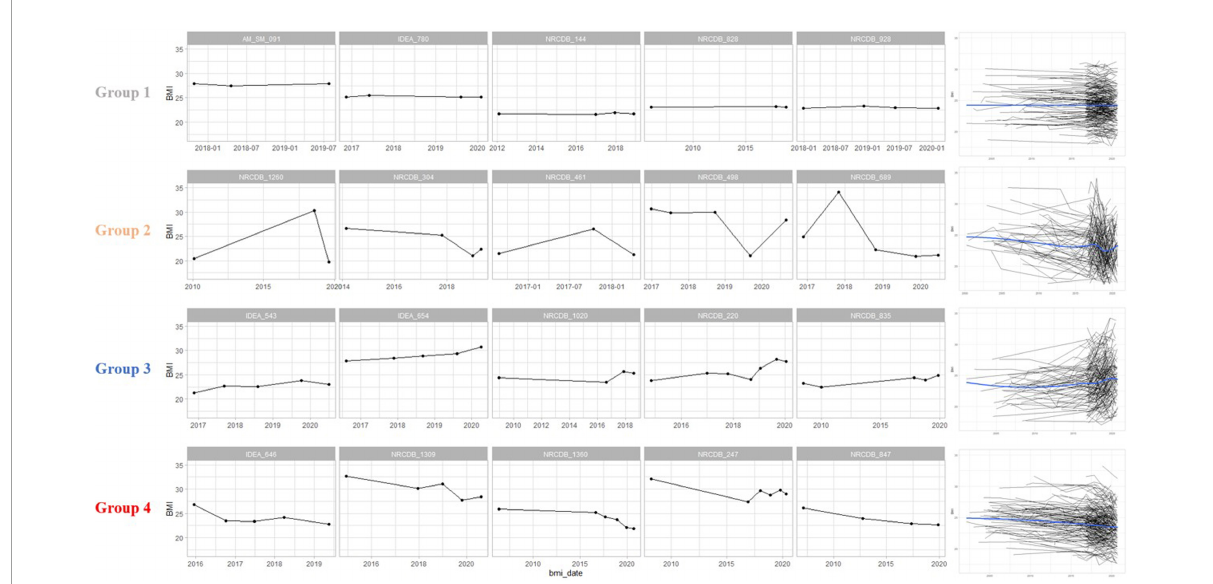
FIGURE1 Body mass index (BMI) patterns of representative participants in each group. Group 1 had a constant pattern of both BMI change and variability. Group 2 showed a constant BMI change and some variability. Group 3 was a cluster with increasing BMI changes and high variability. Group 4 was a cluster with a decreasing BMI changes and high variability. The graphs on the right are spaghetti plots representing the BMI pattern of all patients in each group, and a blue line representing the trend of the group. BMI, body mass index.